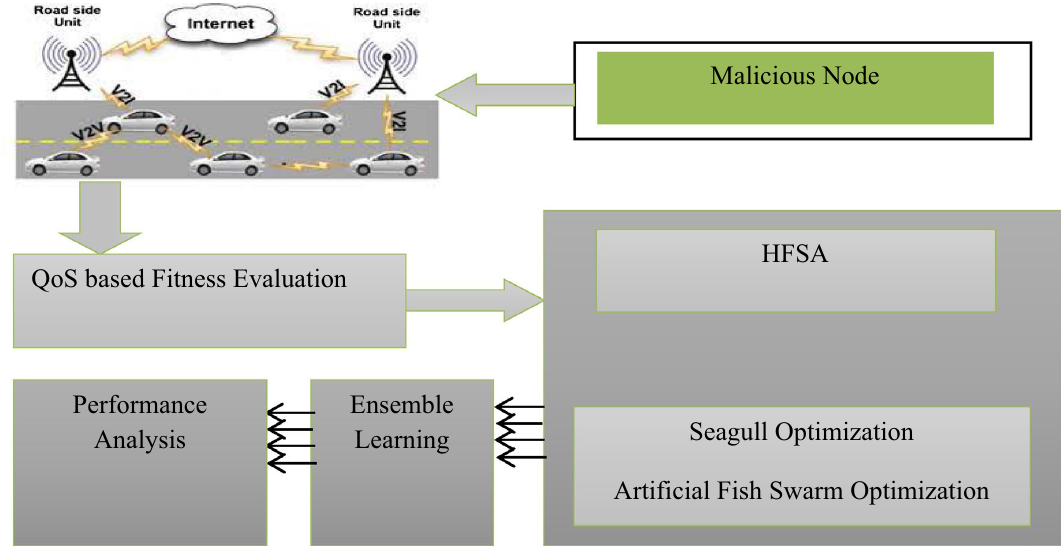
Figure 1. Overall architecture of the proposed